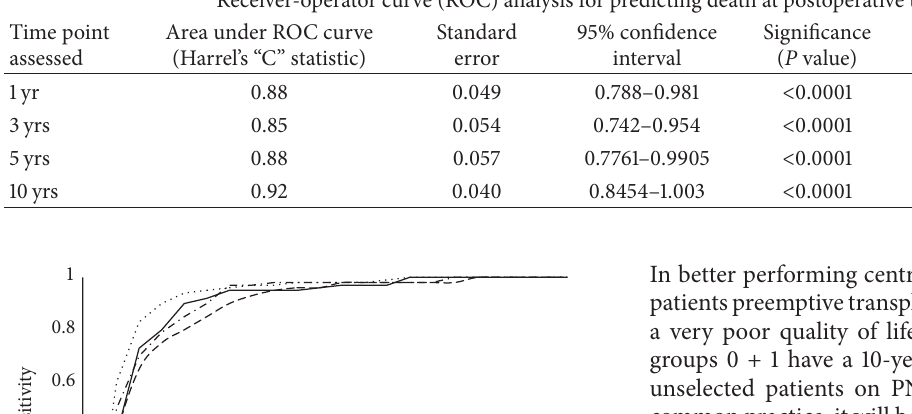
Receiver-operator curve (ROC) analysis for predicting death at postoperative time intervals.